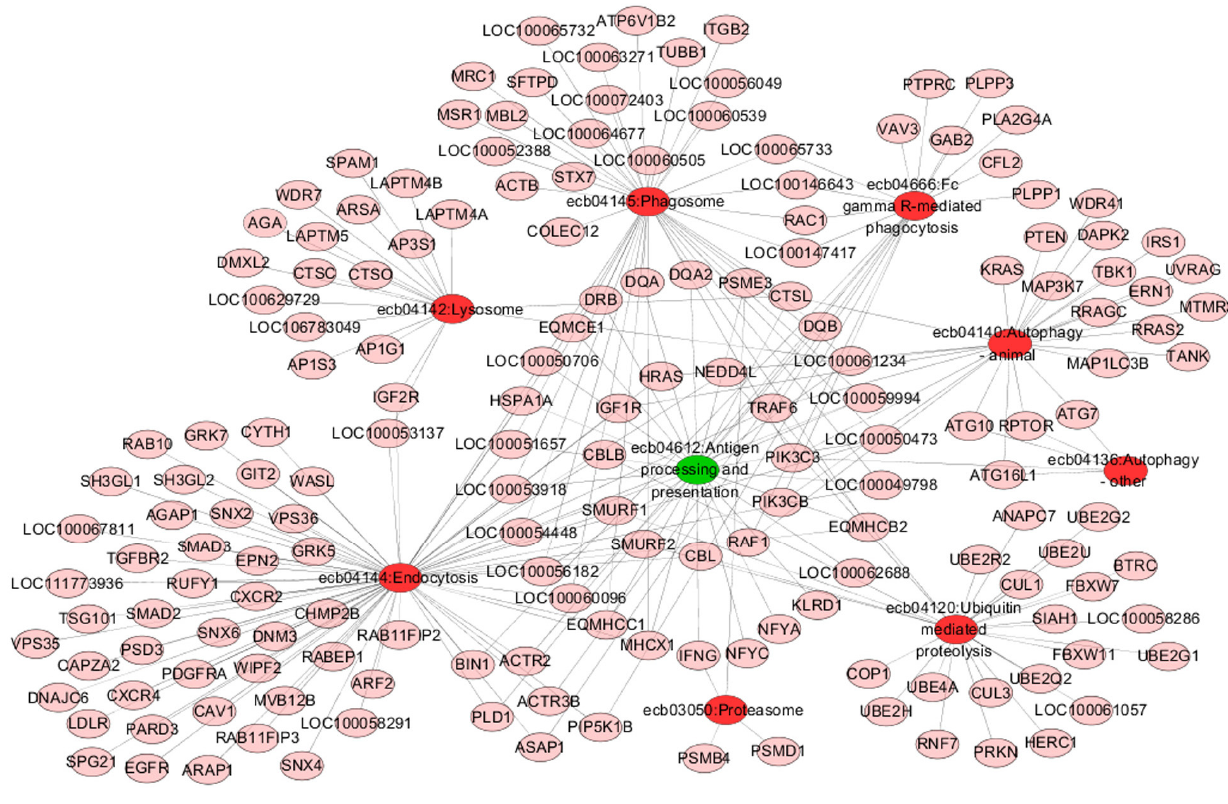
Figure 3. Integrated pathway network analysis of point mutation genes involved in antigen processing and presentation in the mule genome. Green and red represent pathways; pink represents genes.